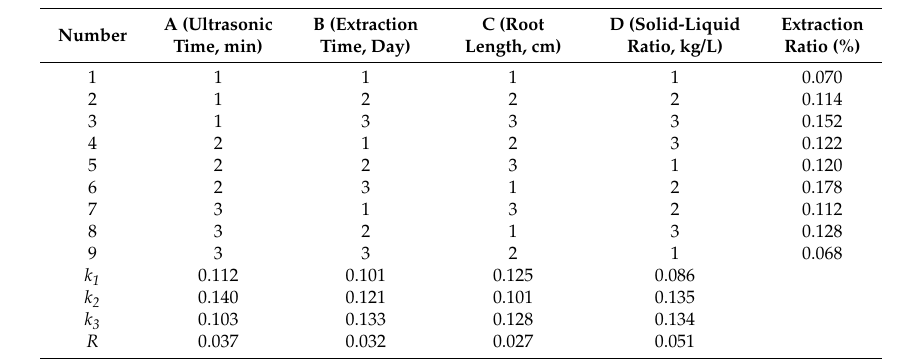
Table 2. Results of the L9 (3) 4 orthogonal